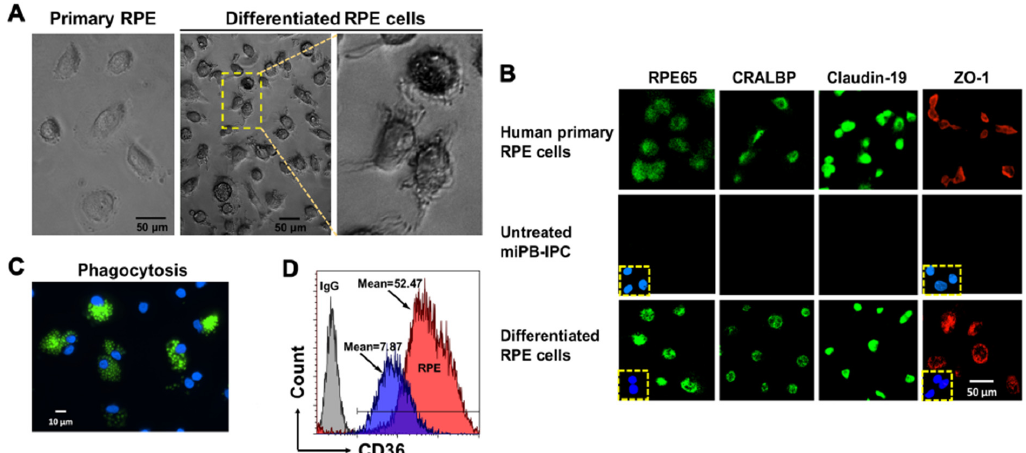
Figure 2. Differentiation of mitochondrion-induced PB-IPC (miPB-IPC) into retinal pigment